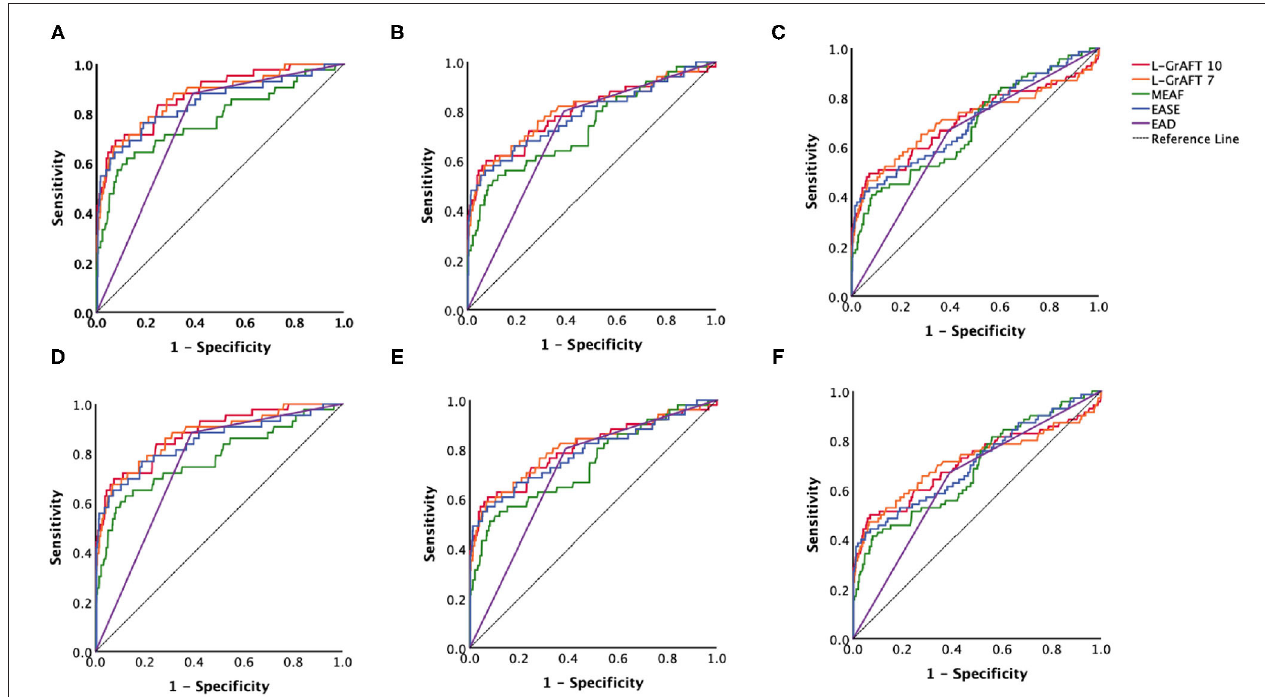
FIGURE 1 | Models accuracies compared by the area under the receiver operating characteristic (AUROC). AUROC curves comparison among L-GrAFT 10 , L-GrAF 7 , EASE, MEAF, and EAD for predicting (A) 3-month patient survival, (B) 6-month patient survival, (C) 12-month patient survival, (D) 3-month graft survival, (E)